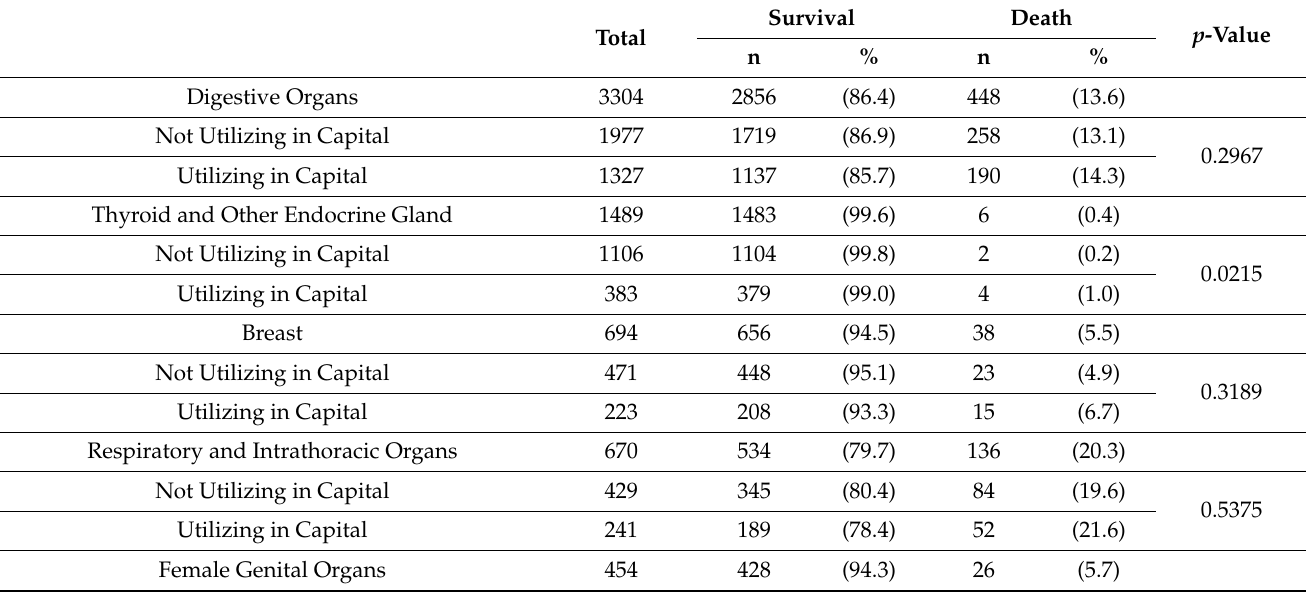
Table 2. Survival and death by cancer according to the use of health care in